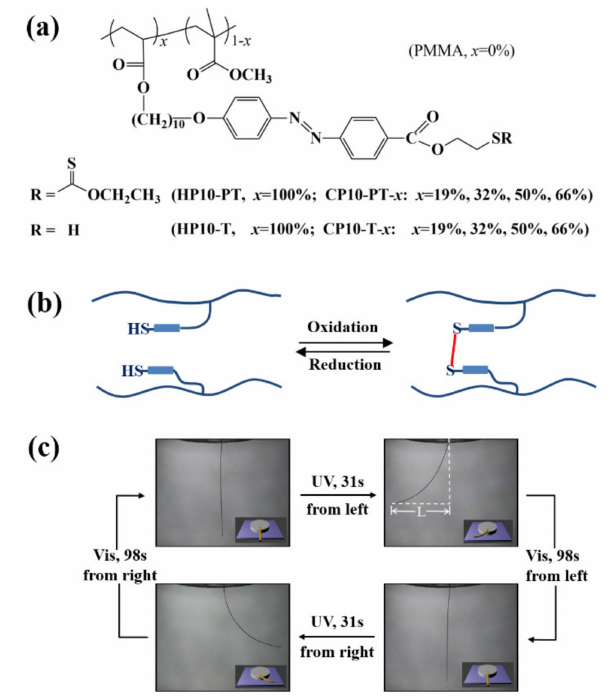
Figure 9. ( a ) Chemical structures of the side-chain polymers bearing azo mesogens with a pro- tected thiol substituent (HP10-PT, CP10-PT- x ( x refers to azo contents in the polymers)) (R = − (C = S)OCH 2 CH 3 ) and those with free thiol-substituted azo mesogens (HP10-T, CP10-T- x ) (R = H). ( b ) Schematic illustration of the reversible switches between thiol and disulfide groups in the uniaxially oriented azo polymer fibers via redox reactions. ( c ) Photographs of the post-crosslinked CP10-T-50% fiber that exhibits photoinduced bending and unbending upon irradiation with 365 nm UV light (150 mW cm − 2 ) and visible light (>510 nm, 120 mW cm − 2 ) at 40 ◦ C. Reprinted with permission from Reference [61]. Copyright 2016 Royal Society of